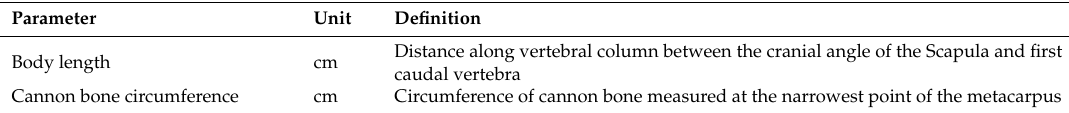
Table 2. Definitions of parameters derived from the